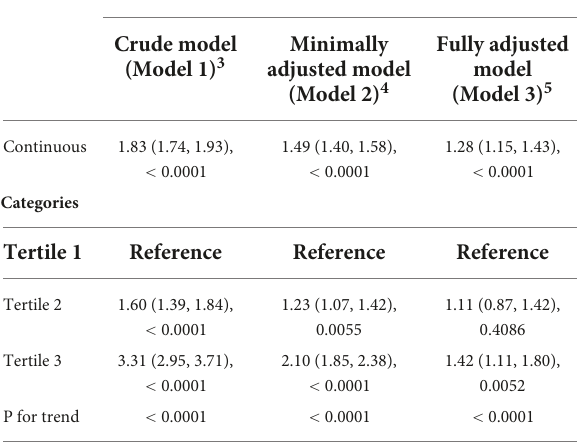
TABLE 3 Multivariate logistic regression models of